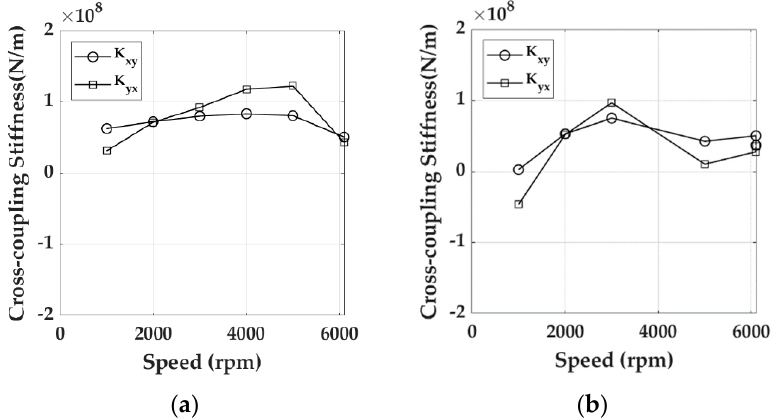
Figure 30. Flooded Rocker Pivot bearing synchronous cross-coupling stiffness: ( a ) 1.3 MPa, ( b ) 2.1 MPa.